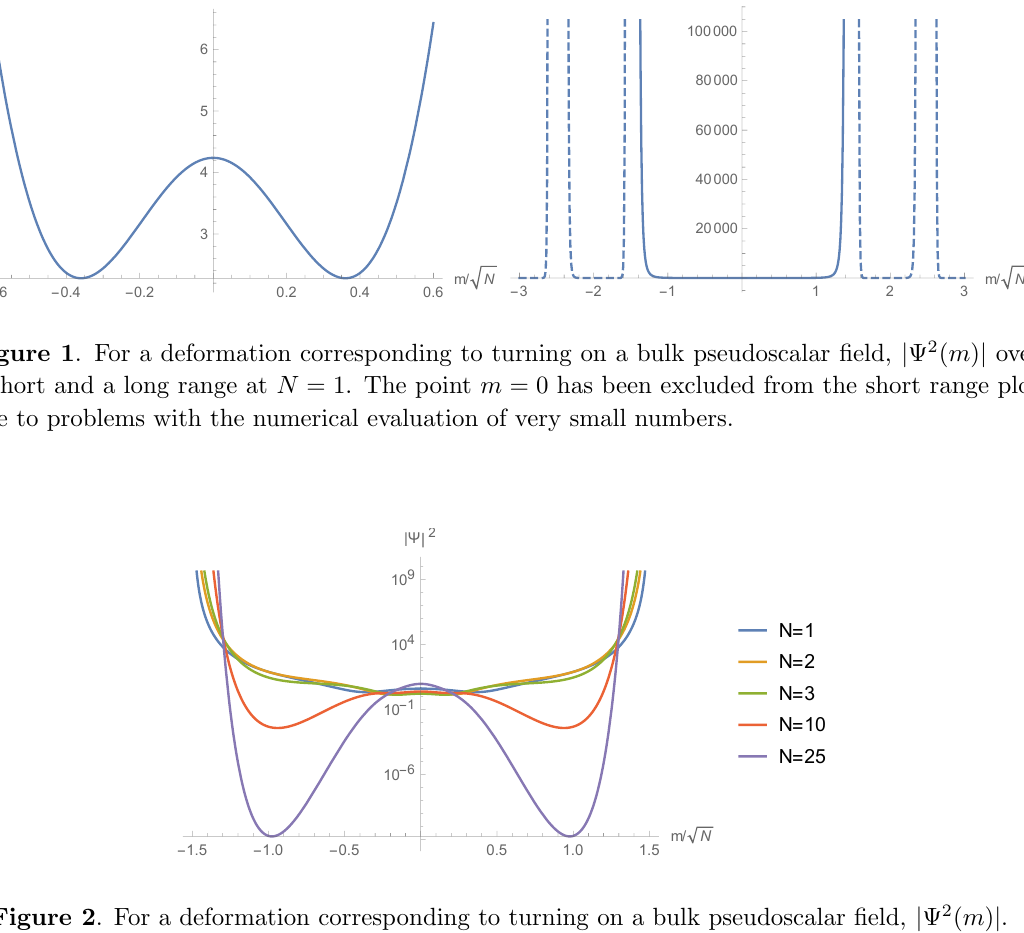
Figure 2 . For a deformation corresponding to turning on a bulk pseudoscalar (cid:12)eld, j (cid:9) 2 ( m ) j .